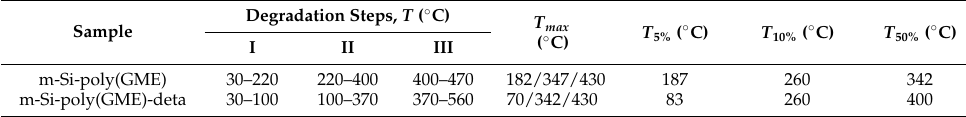
Figure 3. TGA curves of m-Si-poly(GME) and m-Si-poly(GME)-deta. Table 2. The results of TGA for investigated